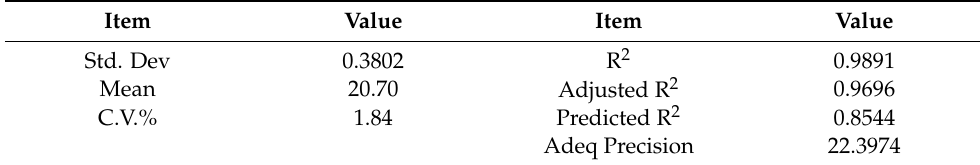
Table 5. Correlation analysis result of experimental model.